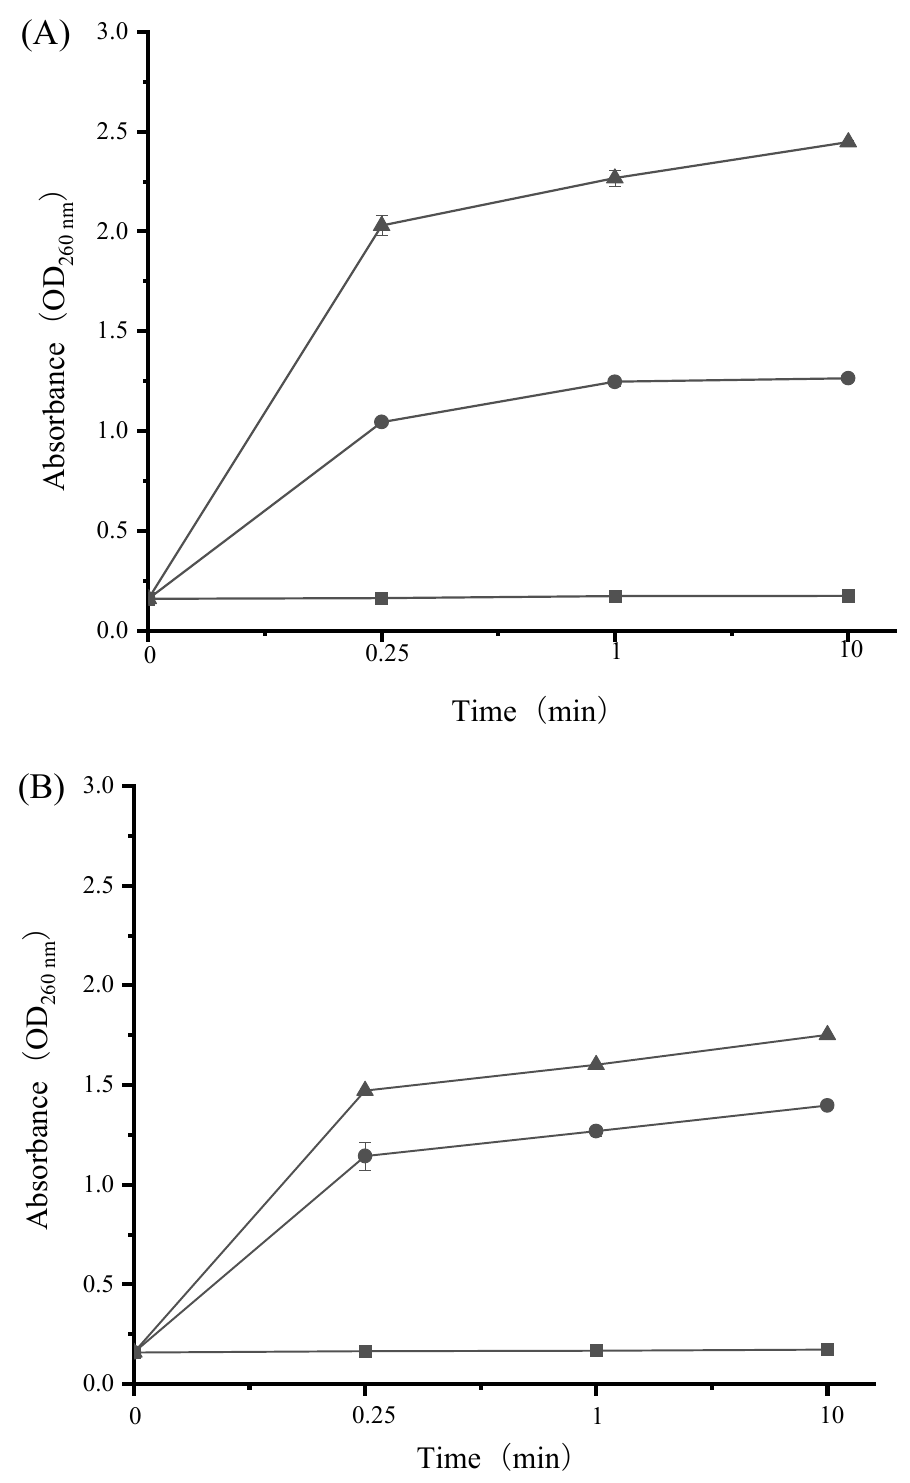
Figure 6. Effect of SAMs on the leakage of intracellular nucleic acids in E. coli ( A ) and S. aureus ( B ) during incubation at 37 °C for 10 min. The following concentrations of SAMs were used: control ( ■ ), 1/2 × MIC ( ● ), and 1 × MIC ( ▲ ). Values are displayed as the mean ± standard deviation. Error bars show standard deviations, which have been plotted for all data points. Symbols without visible vertical bars suggest that the symbol size is larger than the standard deviation.